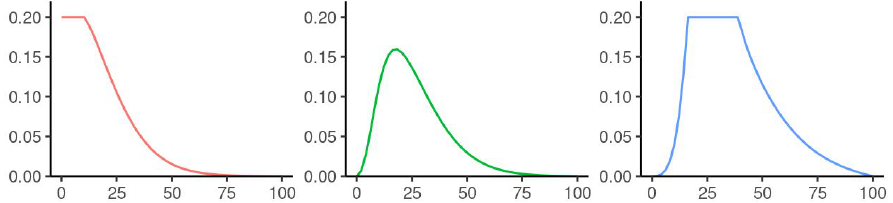
Figure 23. Experiment 4. The structure of the optimal treatment policies u i ( t ) irresponsible individuals.